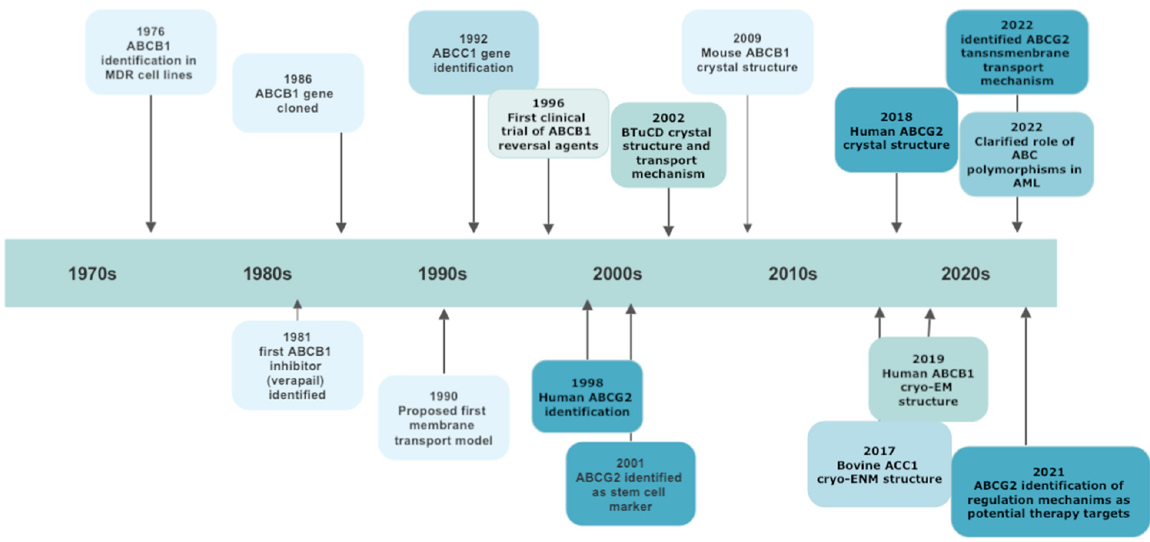
Figure 1. A schematic chronology of signi fi cant discoveries of ABC transporters involved in multi- drug resistance.